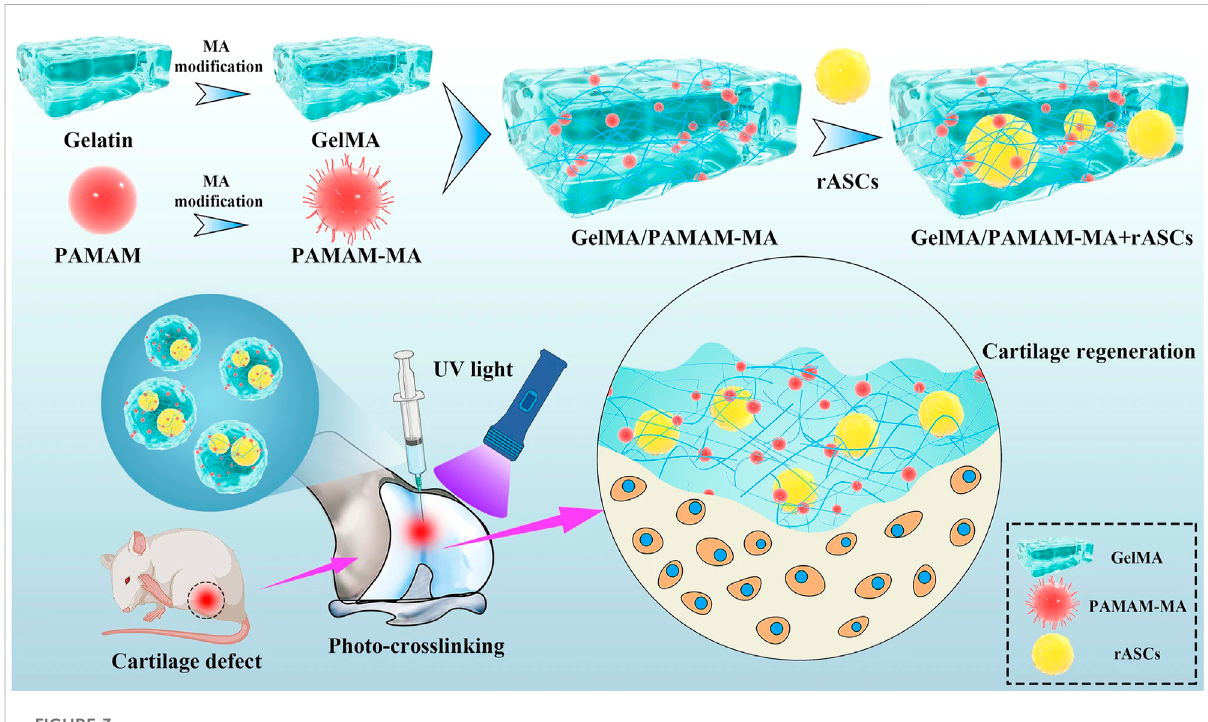
FIGURE 3 Schematic diagram of the injectable stem cell-laden photocrosslinked GelMA/PAMAM-MA hydrogel for cartilage regeneration (Liu et al., 2022) Copyright 2022, Stem Cell Research &